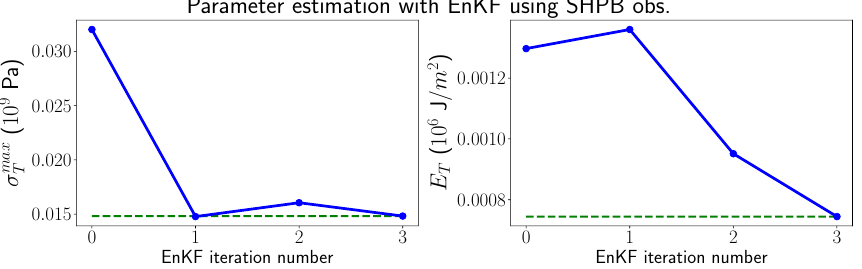
Figure 6. Estimated parameter values for σ max and E t provided by the EnKF data assimilation using t SHPB time–stress curve observations, where the blue line is the average parameter value at each iteration, and the green dashed line is the final value at Iteration 3. The EnKF is applied three times, each time providing an estimated parameter value. The assimilation provides a consistent estimate for σ max , where the parameter value is seen to converge around 0.15. In the case of E t , the assimilation t seems to be providing monotonically decreasing values of the parameter value, which might not be reliable.